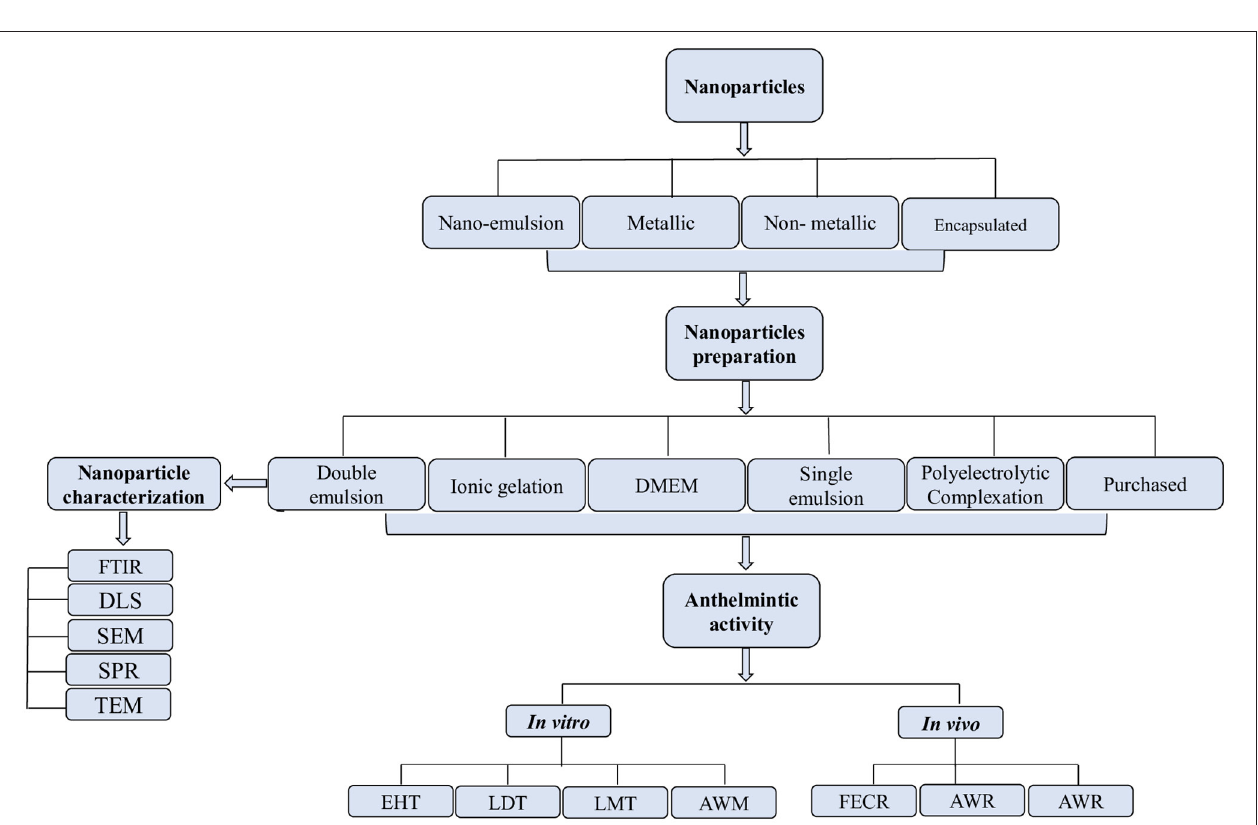
FIGURE 4 | Process of selection, preparation, and characterization of nanoparticles for in vitro / in vivo anthelmintic activity.